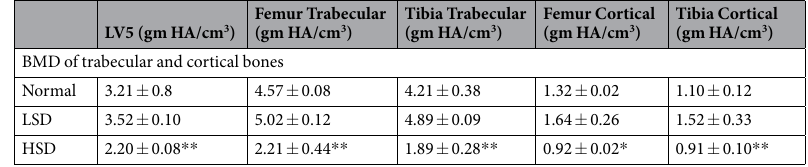
Table 2. High dietary salt intake decreases mineral density of bones. Tabular representation of BMD of trabecular (LV5, femur and tibia) and cortical (femur and tibia only) bones of normal, low salt diet (LSD) and high salt diet groups (HSD). The results were evaluated by using ANOVA with subsequent comparisons by Student t test for paired or nonpaired data, as appropriate. Analysis was performed using Sigma plot software (Systat Software, Inc., Germany). Values are reported as mean ± SEM (n = 10) and similar results were obtained in three independent experiments. Statistical significance was defined as p ≤ 0.05 ( * p ≤ 0.05, ** p ≤ 0.01) with respect to low salt diet group.